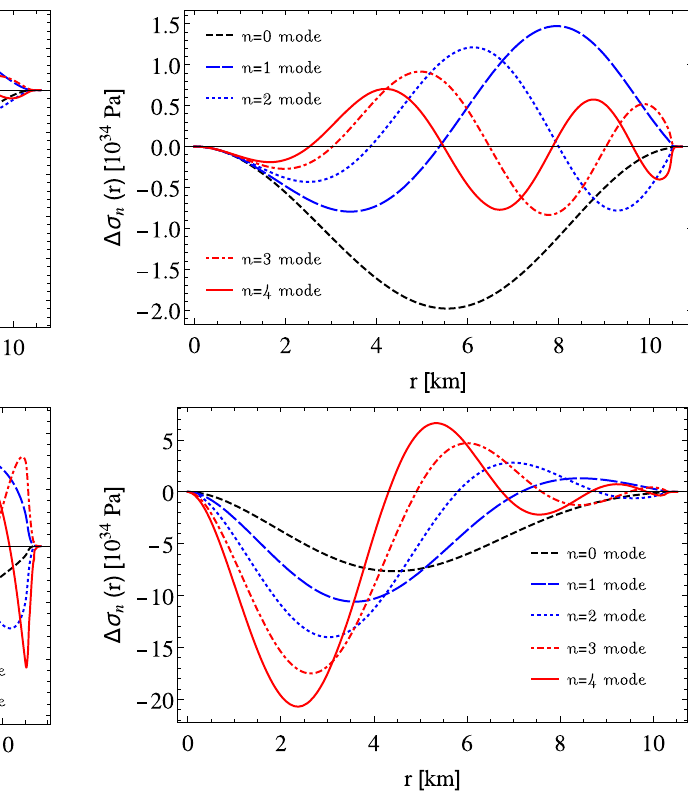
to the anisotropy ansatze (30) with β H = 0 . 5, (32) with β BL = 0 . 25, (34) with β HB = − 0 . 05, and (36) with β R = − 5 . 0 × 10 11 m 3 , respec- tively. The radius, mass, and frequency of the fundamental mode for such stars are shown in Table